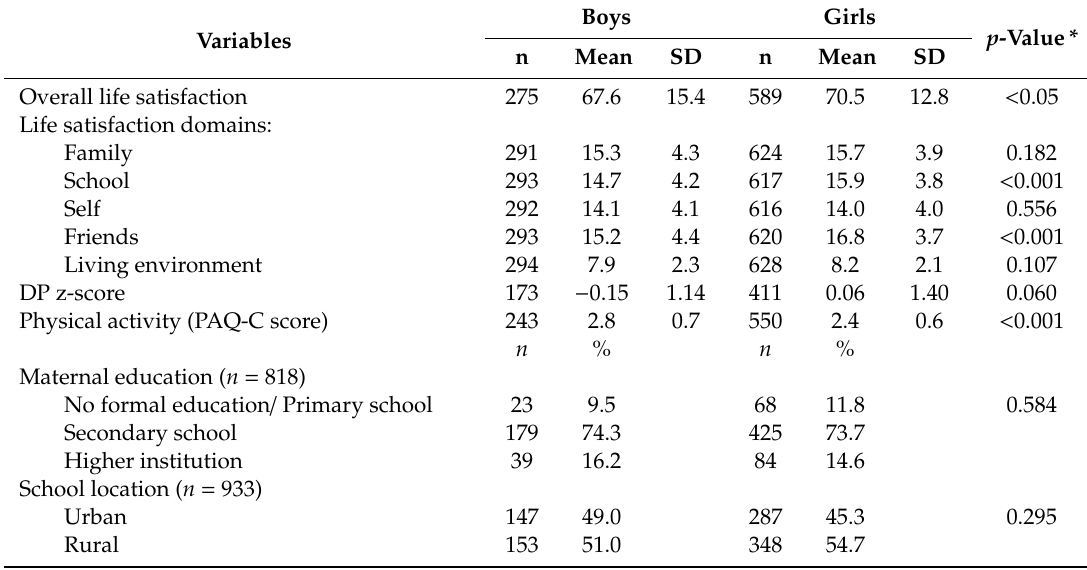
Table 1. Characteristics of study adolescents recruited from three southern states of Peninsular Malaysia.